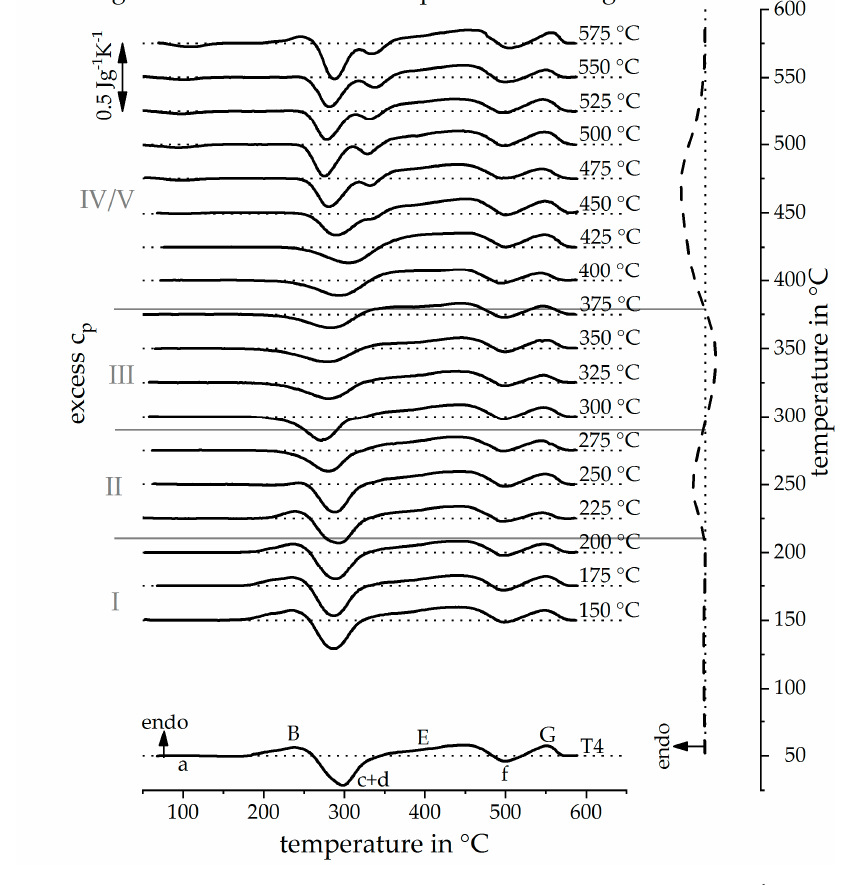
Figure 10. Reheating curves after a heat treatment with a heating rate of 20 Ks − 1 up to different maximum temperatures and the resulting reconstructed heating curve at 20 Ks − 1 .